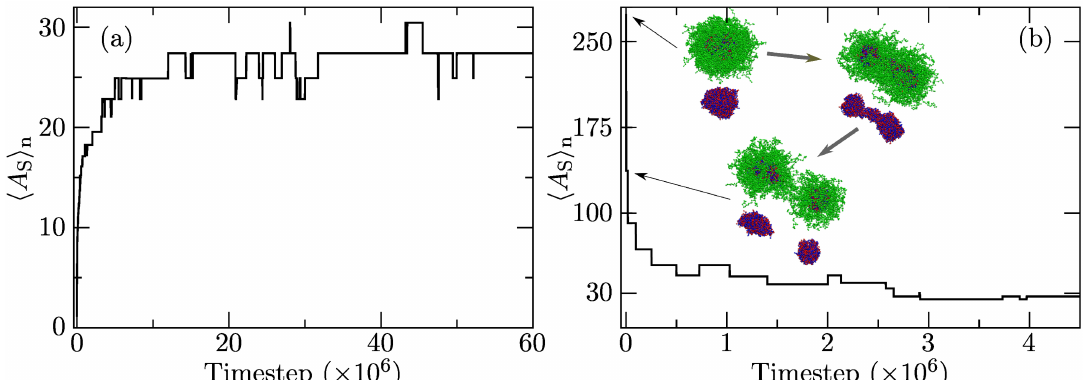
Figure 3. Time evolution of the number-averaged association number, (cid:104) A S (cid:105) n , from ( a ) a fully dissolved state and ( b ) a pre-aggregated state with snapshots of the breakup of the initial associate. In the snapshots, the red and blue beads represent the core-forming A + and A − blocks, respectively, and the green beads represent the shell-forming B blocks (the upper images are whole associates, while the lower ones show their interpolyelectrolyte complex (IPEC)